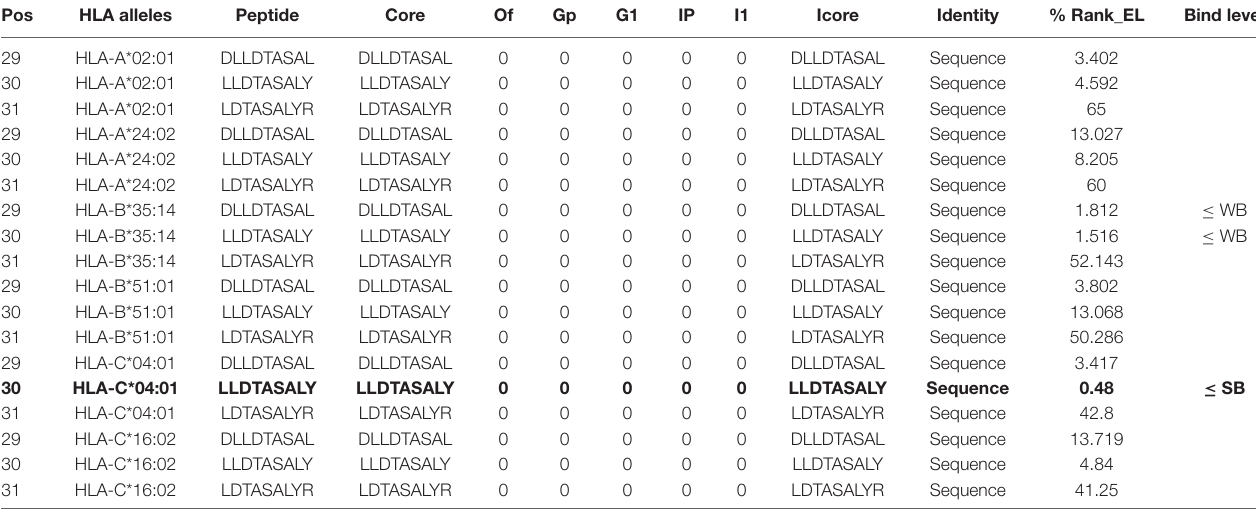
TABLE 2 | Binding affinity prediction of 9-mers peptide with MHC-I molecules in HepG2.2.15